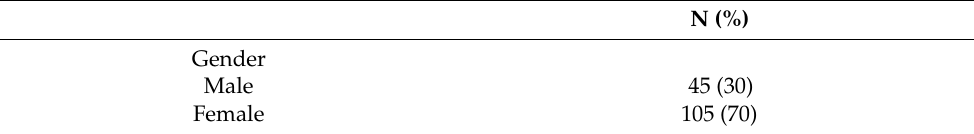
Table 1. Demographic, Financial, and Health-related Characteristics of Sample (n =